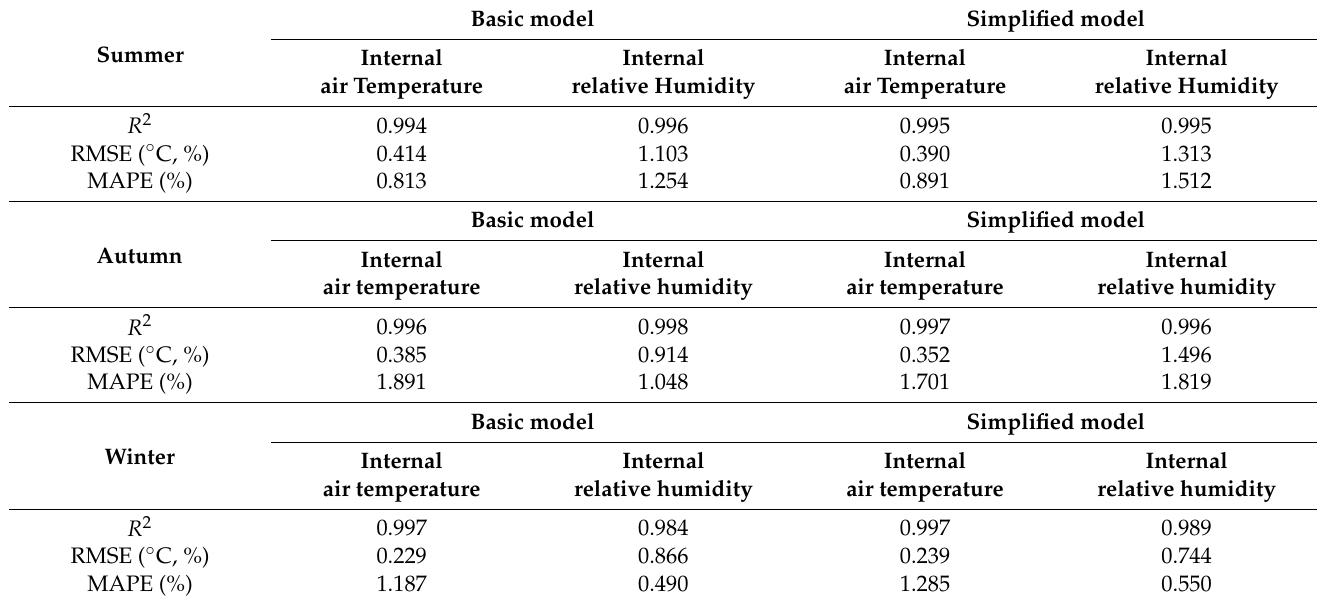
Table 9. Accuracy of RNN model of naturally ventilated duck house according to seasons and variables (reverse